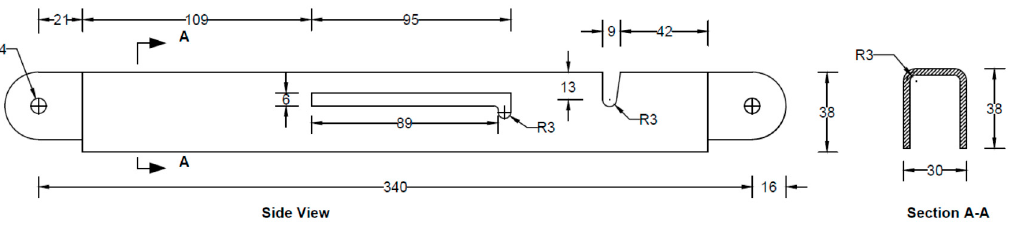
Figure 8. Details of primary folding link bars (all dimensions are in mm, steel plate gauge 11).